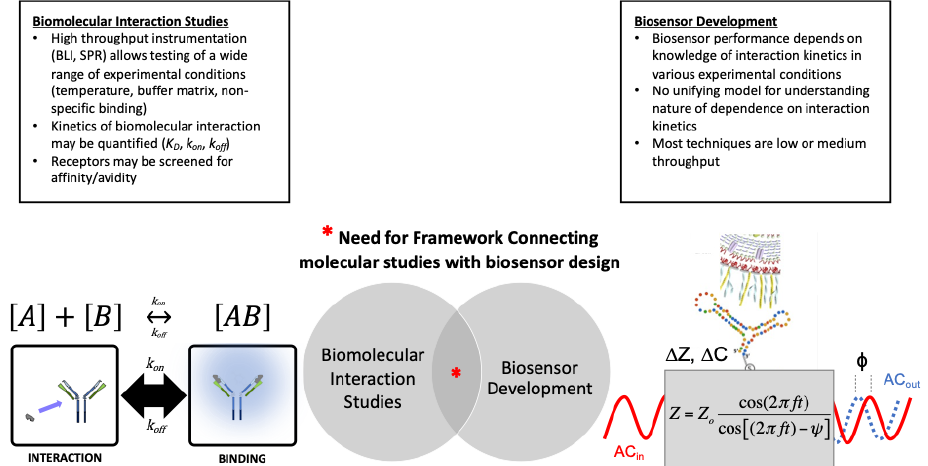
Figure 1. There is a need for frameworks which delineate the relationship between biomolecular interaction studies and biosensor development. High throughput instruments and in silico models for studying biomolecular interactions facilitate detailed characterization of receptor-target affinity under controlled conditions. Biosensor performance is based on knowledge of biomolecular interactions and kinetics, but have relatively low throughput. This article reviews key literature and proposes an experimental approach which may initiate development of a biosensor development framework. We propose one aspect of such a larger framework, focusing on experimental data and we establish an eight-step process. We apply this in a case study that focuses on SARS-CoV-2, utilizing